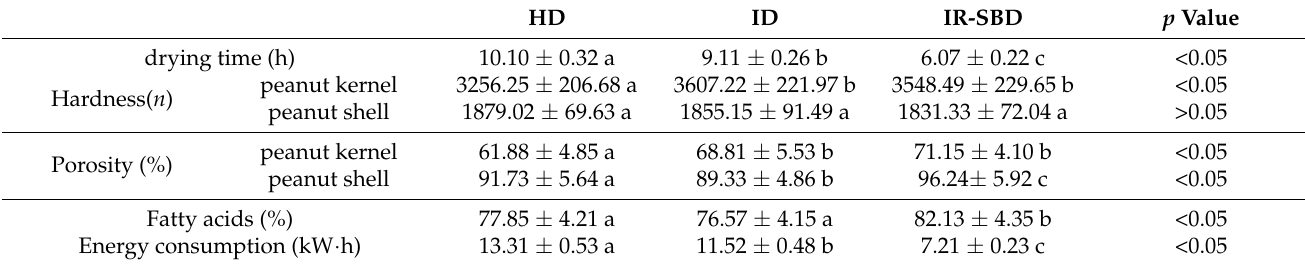
Figure 3. Drying curves ( a ) and drying rate curves ( b ) of whole peanuts under three different drying methods. Table 2.